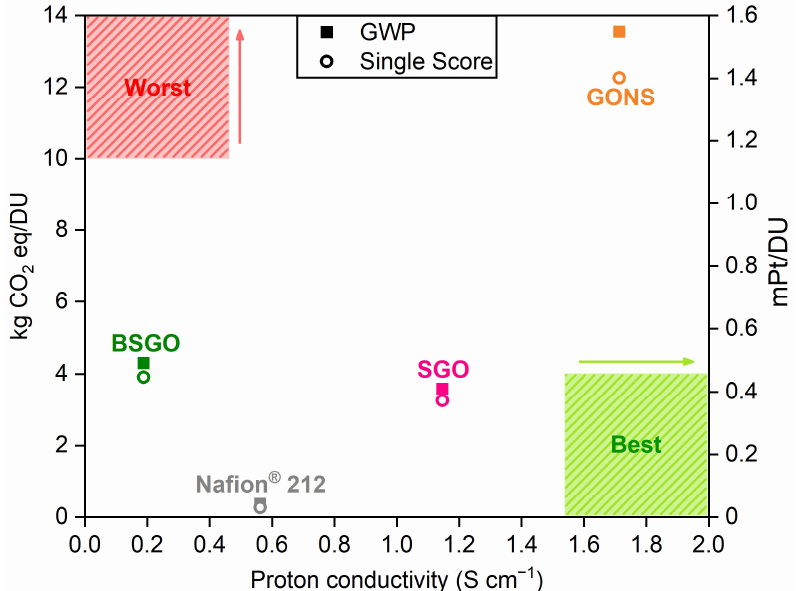
Figure 8. Global Warming Potential (left y -axis) and single-score-weighted EF3.0 results (right y -axis) of Nafion ® 212, SGO, GONS, and BSGO with respect to their corresponding proton conductivity.